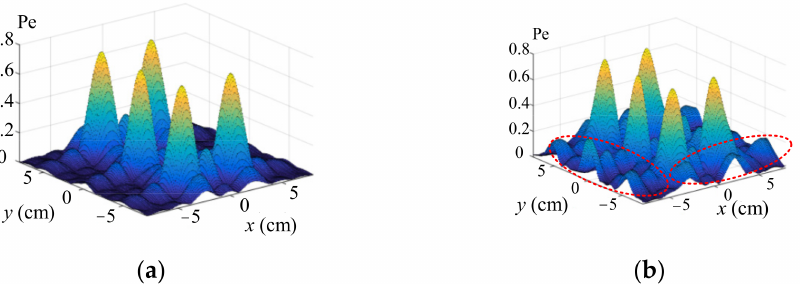
Figure 7. Ultrasound pressure distributions without and with optimization. ( a ) Without optimization. ( b ) With optimization.